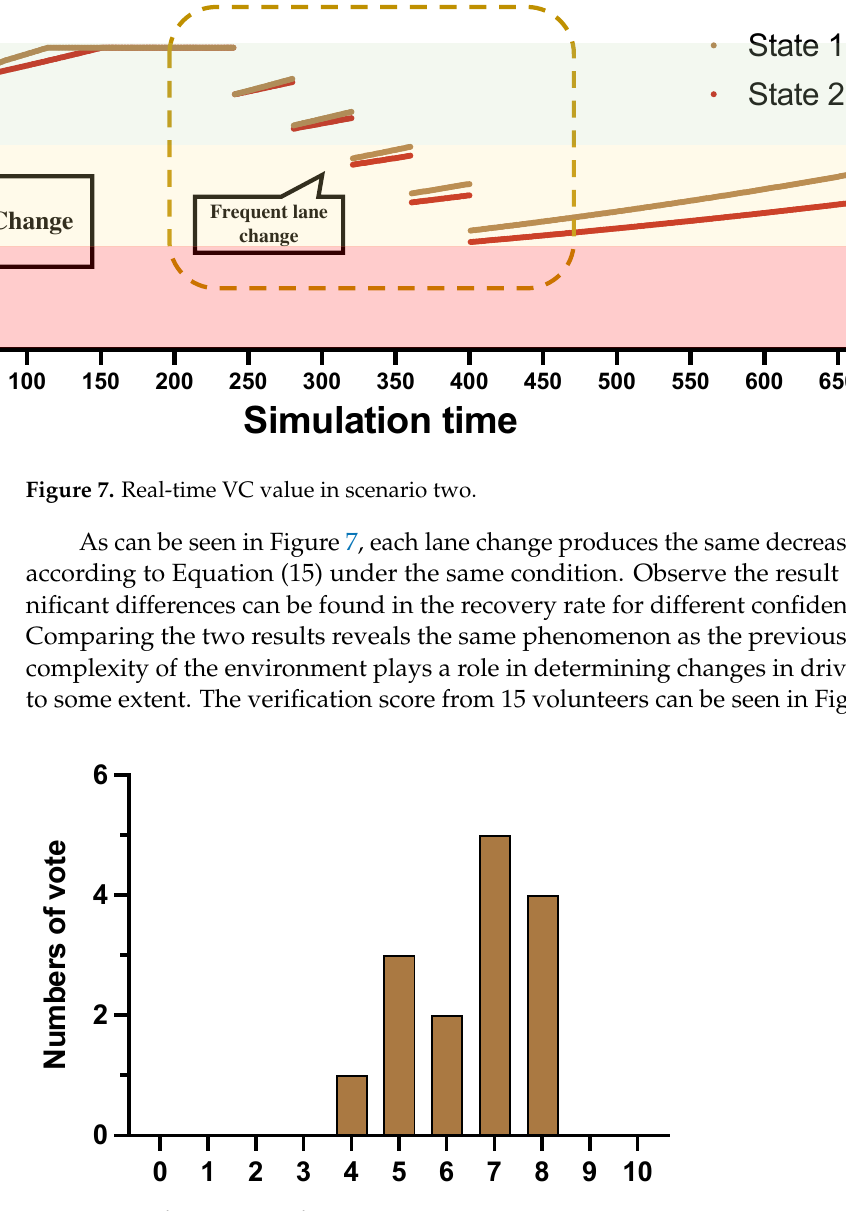
Figure 8. Verification score for scenario